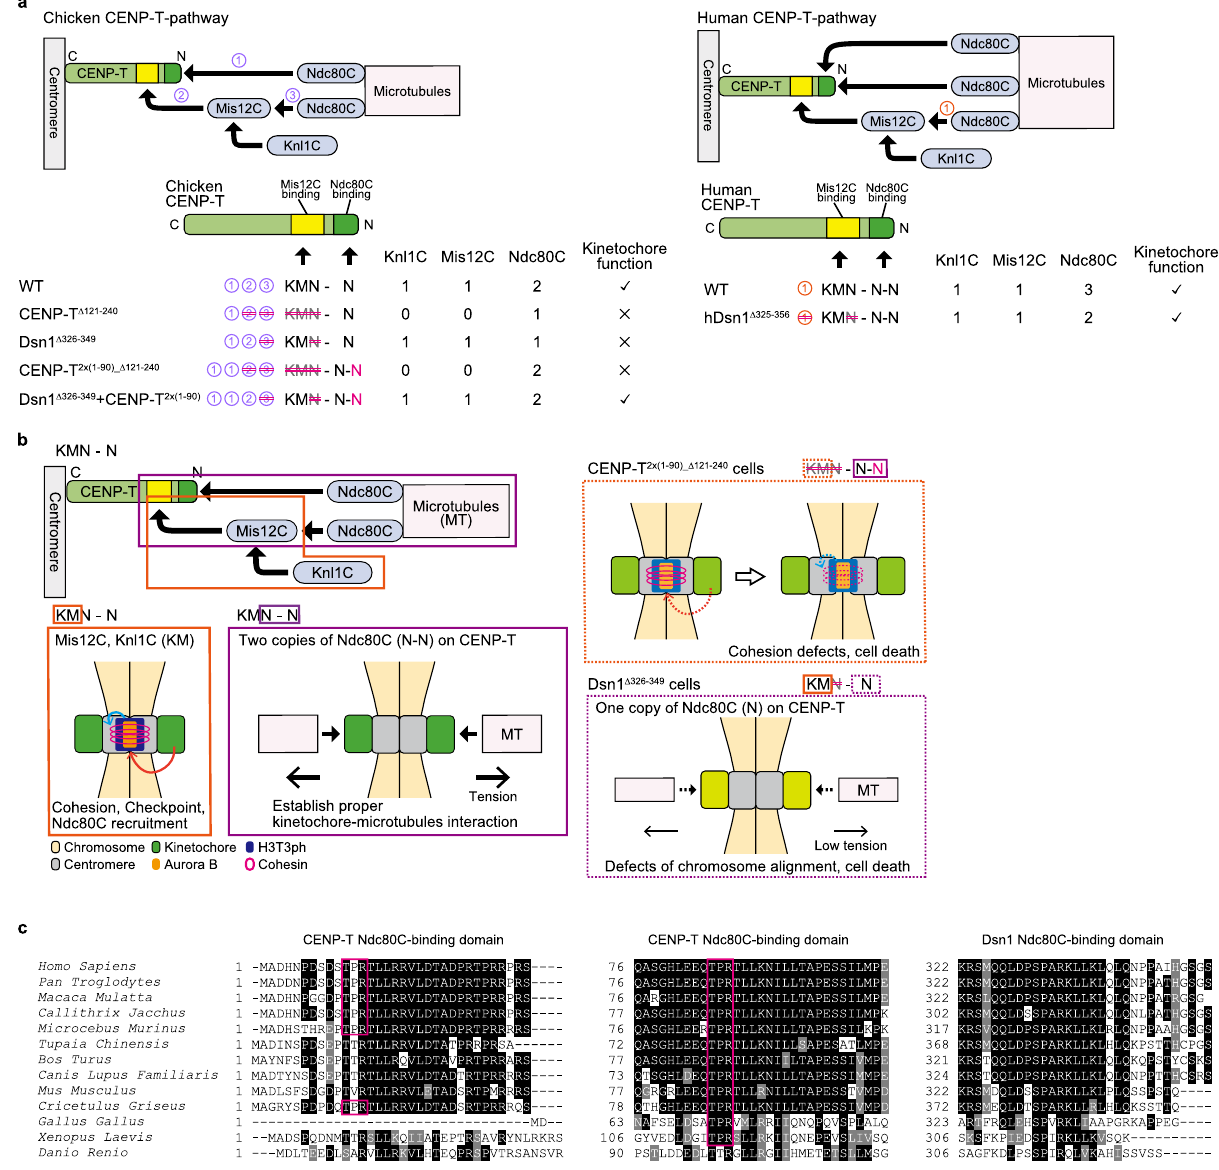
Fig. 7 The KMN network plays distinct roles on CENP-T. a Summary of numbers of K, M, and N in various mutants and their phenotypes in chicken and human cells. b A model of the essential roles of the KMN network on the CENP-T pathway. KM recruits Bub1, H3T3ph, and Aurora B to maintain sister chromatid cohesion and bind to checkpoint proteins. In addition, KM recruits one Ndc80C copy. However, two copies of Ndc80C (N-N) are critical for the establishment of kinetochore-microtubule interactions. As Ndc80C is not necessary to bind to Mis12C, KM and N-N are separable. In CENP-T 2X(1-90)_ Δ 121-240 cells (N-N lacking KM), cohesion defects were still observed, even if suf fi cient amounts of Ndc80C were bound to kinetochores. In Dsn1 Δ 326-349 cells (KM-N lacking one N), only one copy of Ndc80 localized kinetochores, and proper chromosome alignments did not occur, while cohesion defects were not observed. c Amino acid sequence alignments of the CENP-T extreme N-terminal region, conserved second N-terminal region, and Dsn1 C-terminal end for Ndc80C binding between various